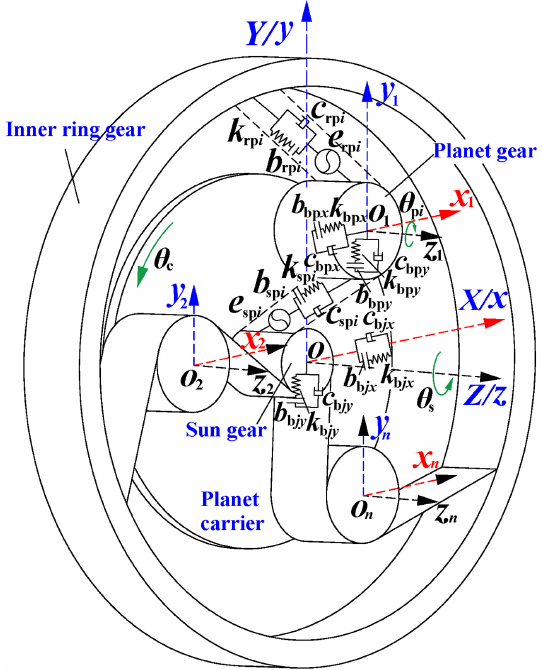
Figure 1. Bending torsion coupling the nonlinear vibration model of the planetary gear transmission